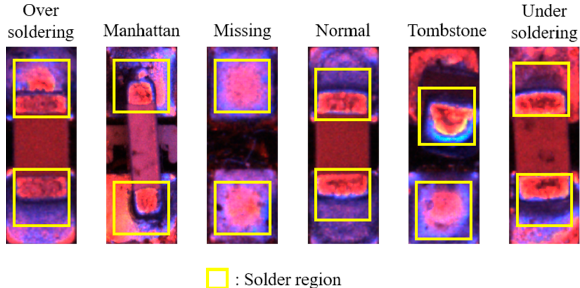
Figure 6. Solder region of chip image. The solder region has different shapes according to the defect type. In the above images, the closer the pixel value is to red, the flatter the slope, and the closer to blue, the smoother the slope. It is easy to classify the defect by only considering the solder region of the chip image, because the defect features are gathered in the solder region. This is especially true for solder defects such as over-soldering and under-soldering.